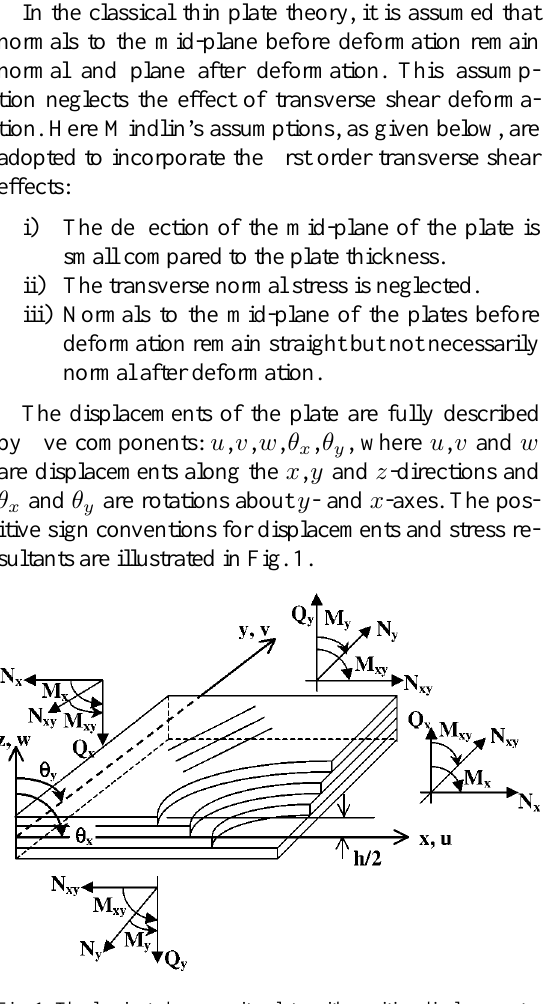
Fig. 1. The laminated composite plate with positive displacements, rotations and stress